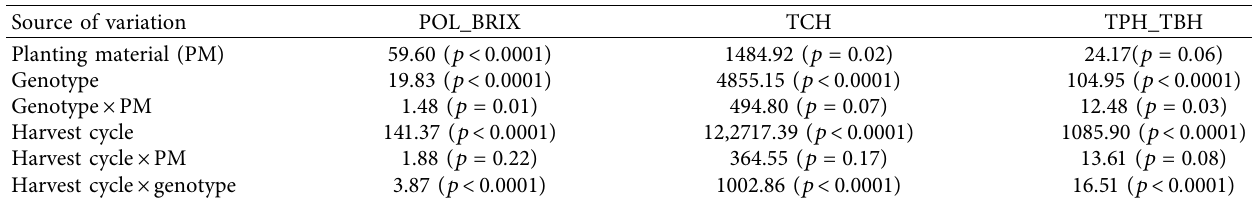
Table 3: Mean squares (MS) and p values pooled joint analysis of variance. Conventional fixed model, with planting material type as test and harvest cycle (plant cane, 1st ratoon) as split-plot, was